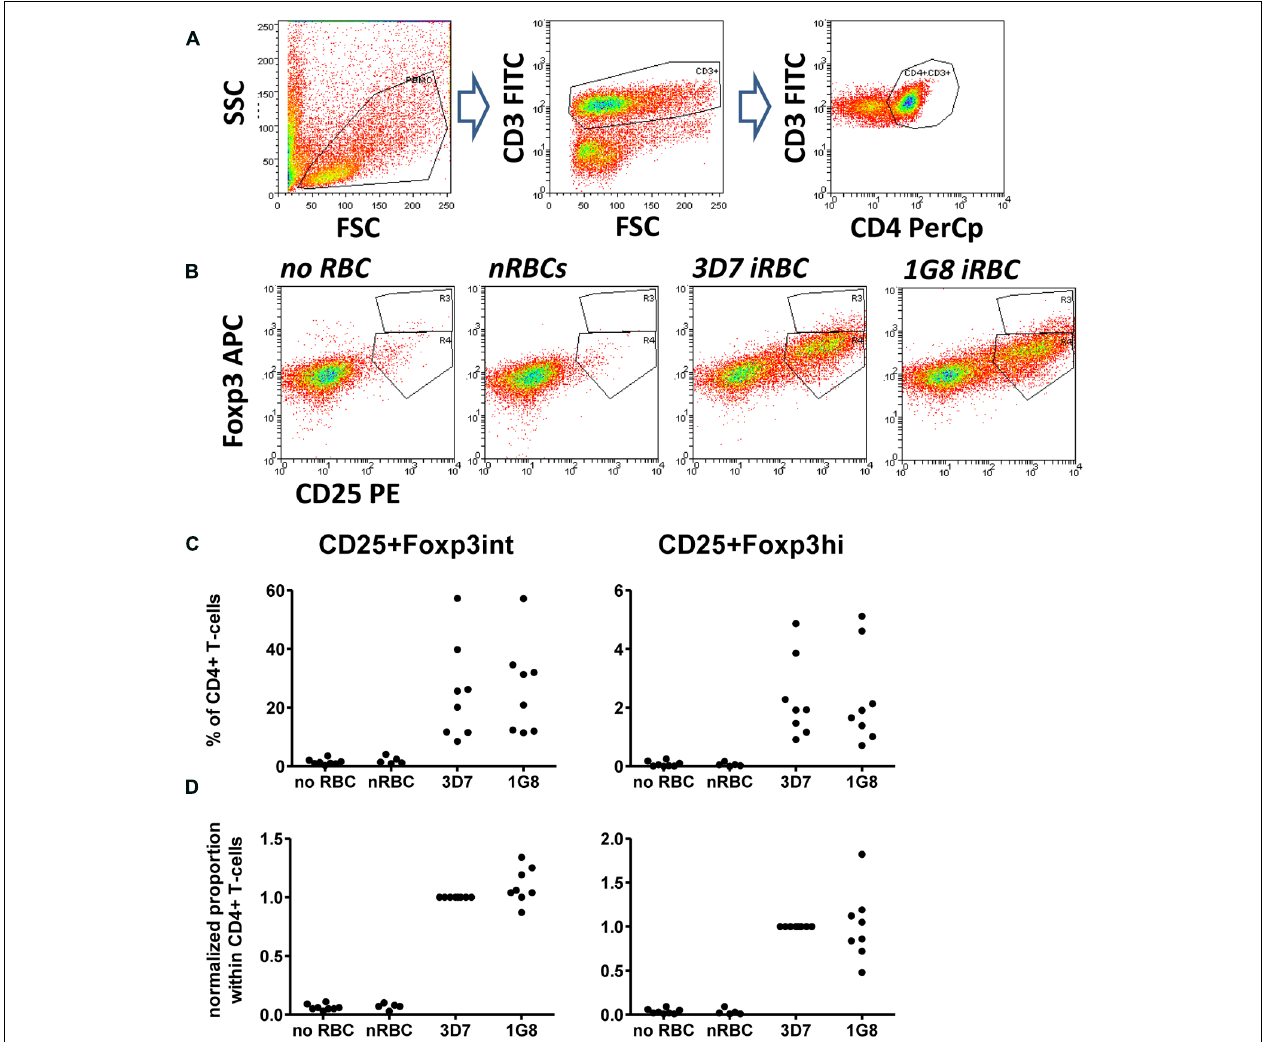
FIGURE 1 | Infected red blood cell (iRBC)-mediated Foxp3 expression is independent of surface Pf EMP-1 expression. PBMC were cultured alone or in the presence of normal (nRBC) or infected RBCs (iRBC) at an RBC:PBMC ratio of 2:1. RBCs were infected with either the parental strain 3D7 or the SBP-1 knock-out parasite line 1G8. On day 6, cells were harvested and analyzed by flow cytometry. (A) Lymphocytes were selected by FSC/SSC gating and further gated based on CD3 and CD4 staining. CD4 + T cells were